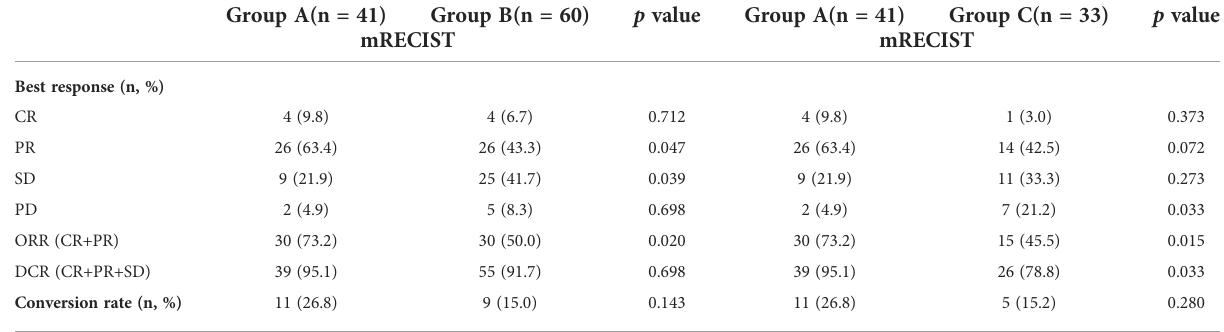
TABLE 3B Subgroup analysis according to macrovascular invasion and extrahepatic metastasis (Group A vs Group B; Group A vs Group C). Group A(n = 41) Group B(n = 60)